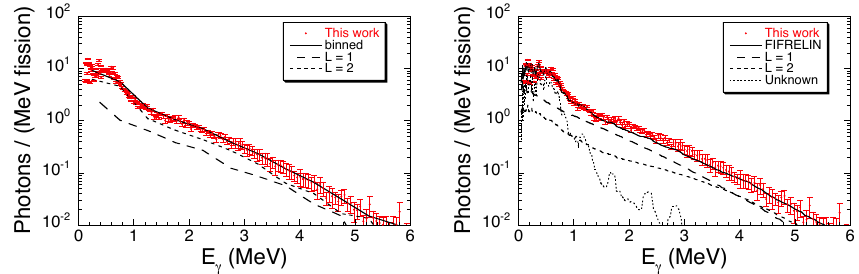
Figure 4. Measured PFGS for 252 Cf(sf) from this work, depicted by red dots. In the left part it is compared to the rebinned spectrum of 500 keV intervals (full black line), from which the contributions for dipole (L = 1) and quadrupole (L = 2) radiation were determined (long and short dashed lines, respec- tively). The right part shows in addition to the measured spectrum a spectrum and its contributions for L = 1 and L = 2 as well as a contribution for which the multipolarity is unknown (all three as black lines), calculated recently with FIFRELIN (see text for